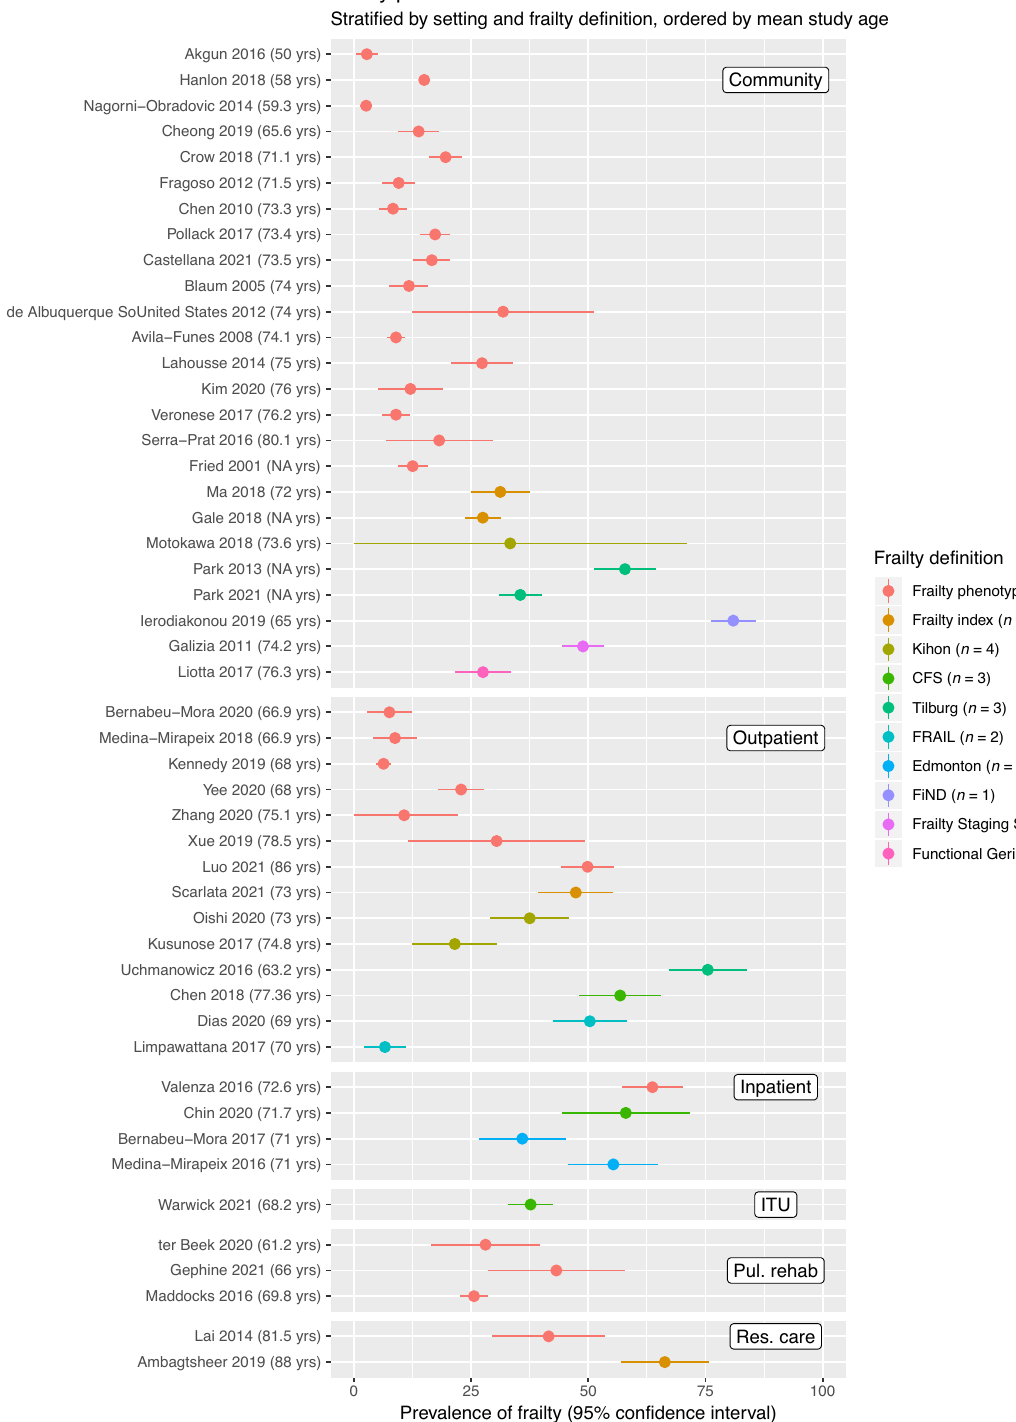
Fig. 4 Plot showing the prevalence of frailty in each of the included studies. Studies are strati fi ed by setting (community, outpatient, inpatient, intensive care (ITU), pulmonary rehabilitation and residential care). Within strata, studies are ordered by frailty measure (colour) and mean age (descending order on y-axis). Points indicate the prevalence estimate, lines indicate 95% con fi dence Quality of life . Four studies assessed the cross-sectional relation- cross-sectional associations between frailty and self-reported ship between frailty and quality of life. Three of these, all of which dyspnoea. As mentioned above, baseline dyspnoea was also used the short-form 36 quality of life assessment, reported lower associated with worsening frailty status over 2 years follow-up in quality of life scores in participants with baseline frailty (2 frailty the only longitudinal study to assess this outcome.